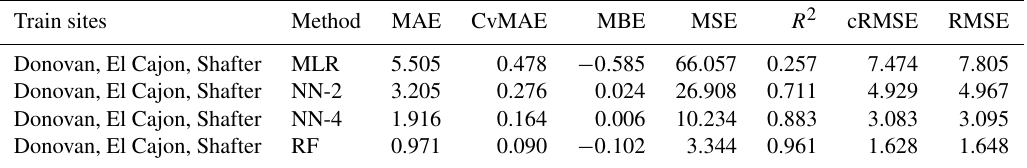
Table C13. Level 3 train results for NO 2 (train and test on the same data set).